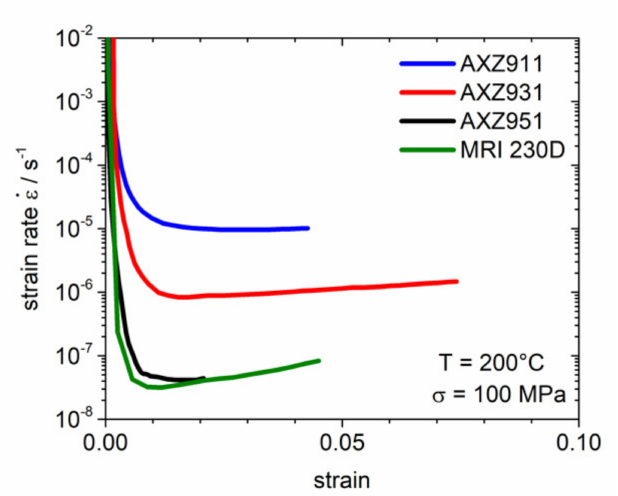
Figure 3. Creep curves of the different alloys measured at a temperature of 200 ◦ C and a compressive stress of 100 MPa; creep data for the alloy MRI 230D are taken from